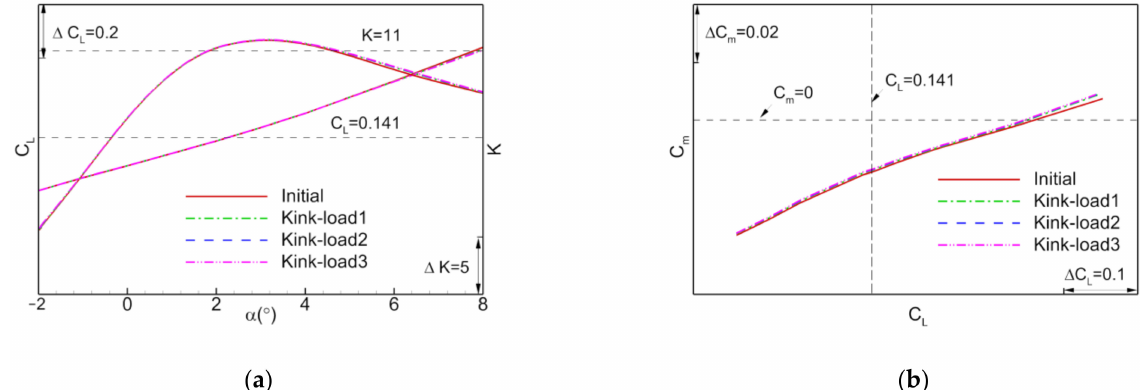
Figure 17. Aerodynamic characteristic of the configurations with different fore-loading kink airfoils. Ma = 0.85, H = 11 km, α = − 2 ◦ ∼ 8 ◦ , ∆ α = 2 ◦ . ( a ) Lift coefficient, lift to drag ratio; ( b ) Pitching moment.